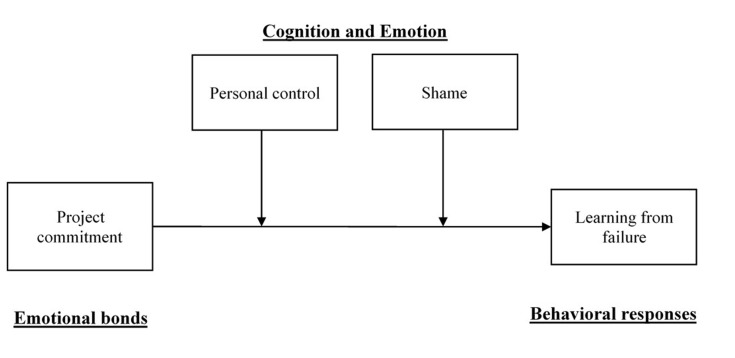
Theoretical model.